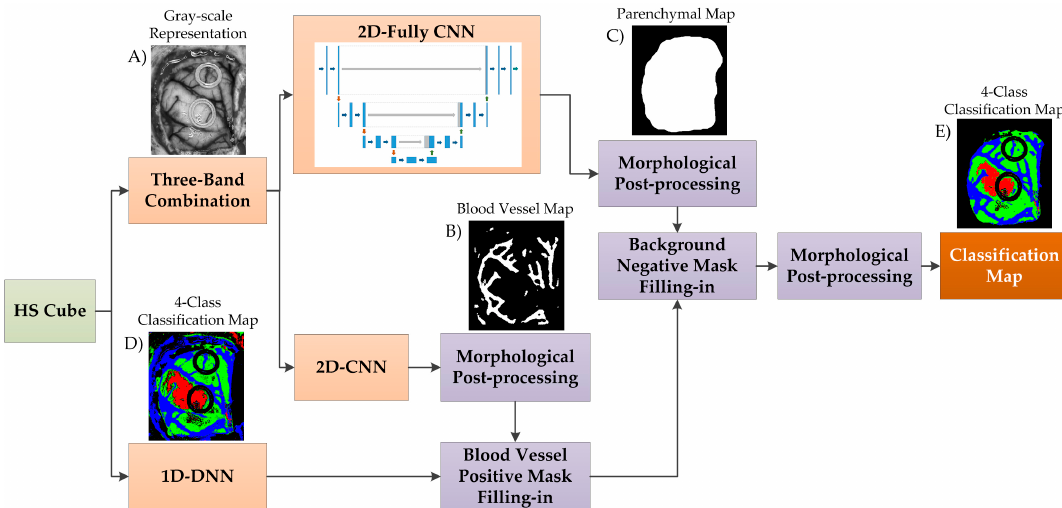
Figure 2. Block diagram of the proposed deep learning framework. ( A ) Gray-scale representation employed as input for the deep learning parenchymal and blood vessel detection algorithms. ( B ) Blood vessel binary classification map. ( C ) Parenchymal binary classification map. ( D ) Four-class classification map obtained from the 1D-DNN algorithm. ( E ) Final four-class classification map generated by the proposed deep learning